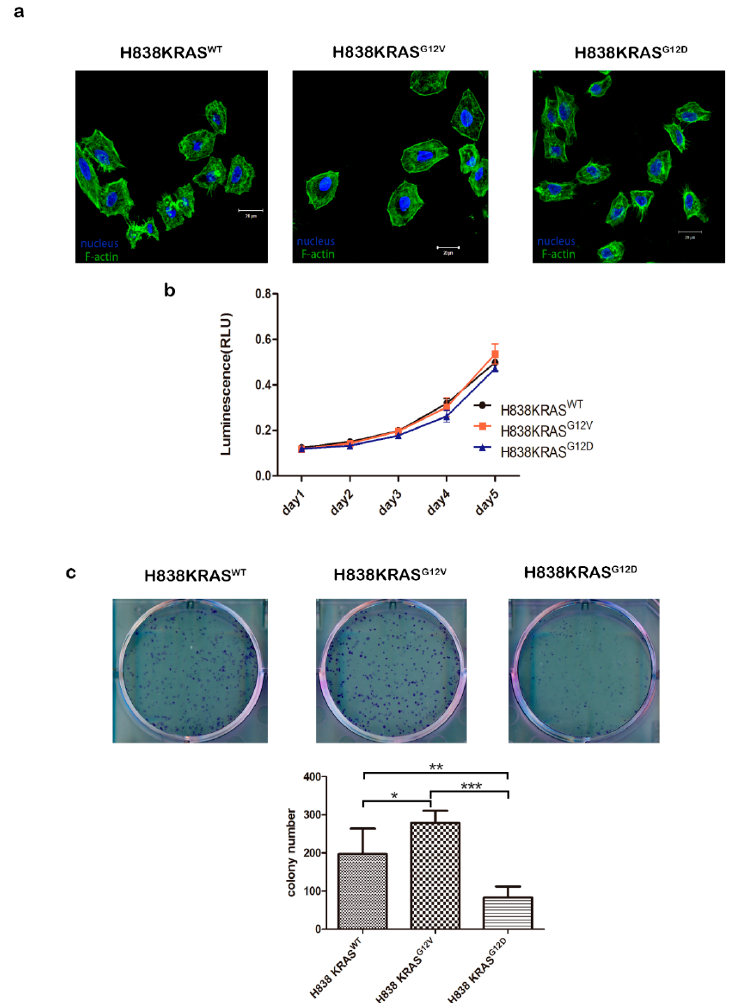
Figure 1. KRAS G12V and KRAS G12D mutations do not affect cell proliferation. ( a ) Immunofluorescence (IF) staining of F-actin in H838 KRAS isogenic cell lines. F-actin is visualized by fluorescent